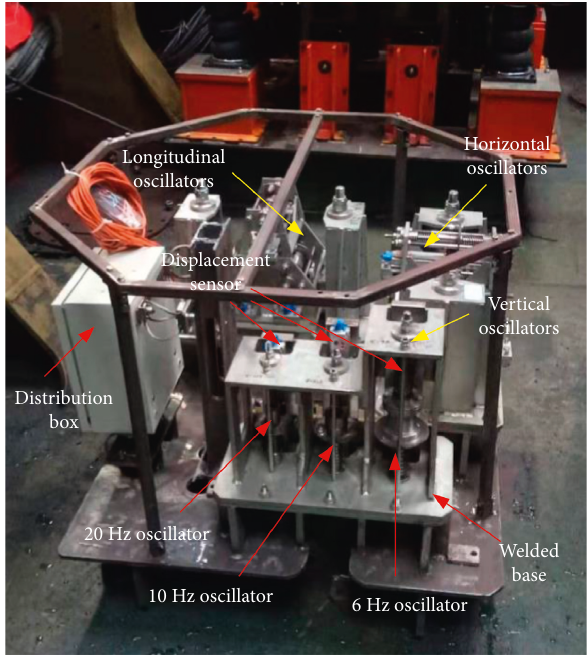
Figure 3: The photograph of the low-frequency oscillator group. Table 2: Displacement and pseudovelocity data from the vertical low-frequency oscillator system. Test condition